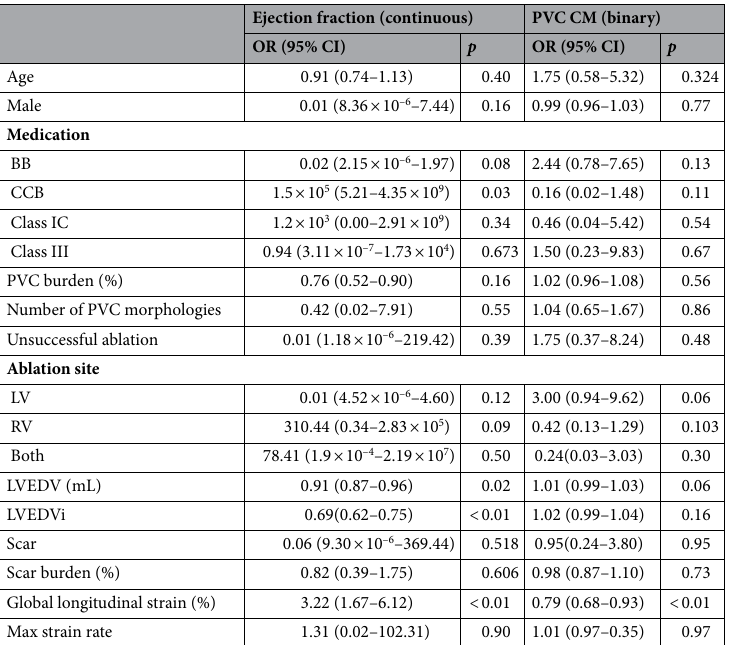
Table 3. Correlation of patient data with PVC cardiomyopathy and on ejection fraction.